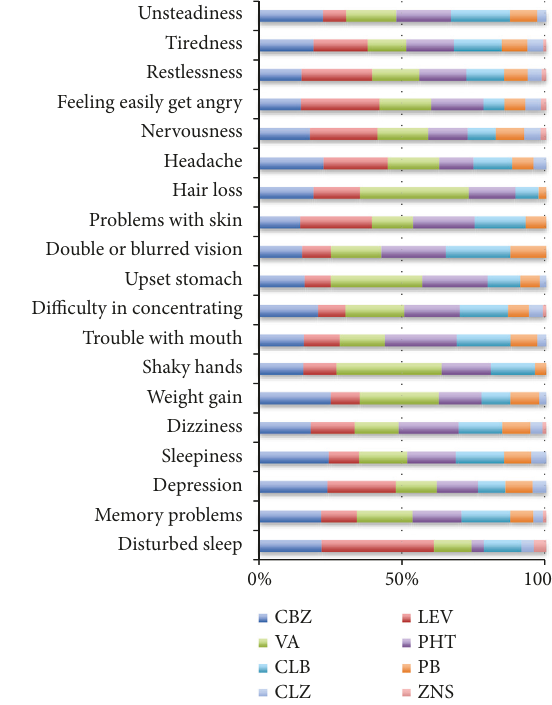
Figure 1: Type of AED treatment and the occurrence of